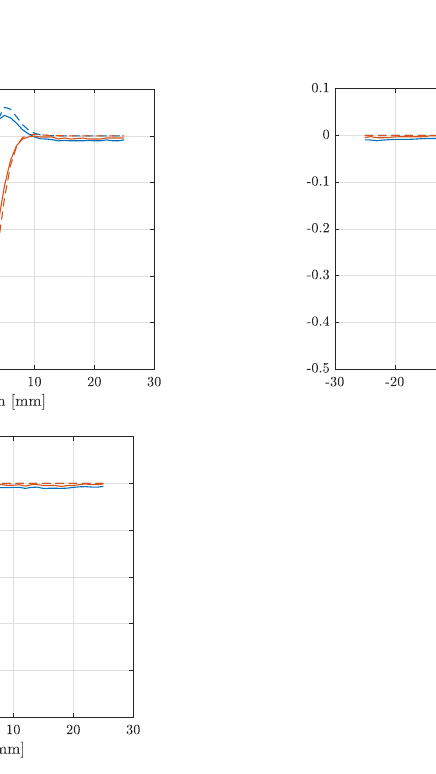
Figure 4. Active impedances R (red) and reactive impedances X (blue) obtained experimentally ( − ) and by numerical simulations ( −− ) for three SDHs of 2.5 mm radius and located at 1 ( a ), 3 ( b ) and 7.5 mm ( c )